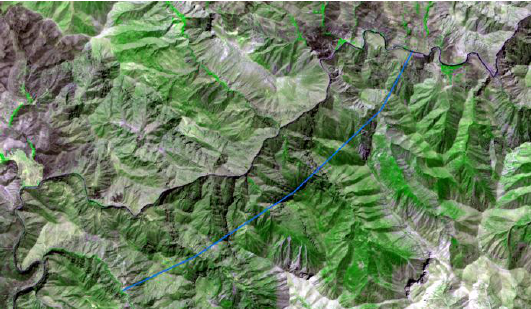
Fig 3. 3D location (top) and the geology map (down) of the Nosoud tunnel.